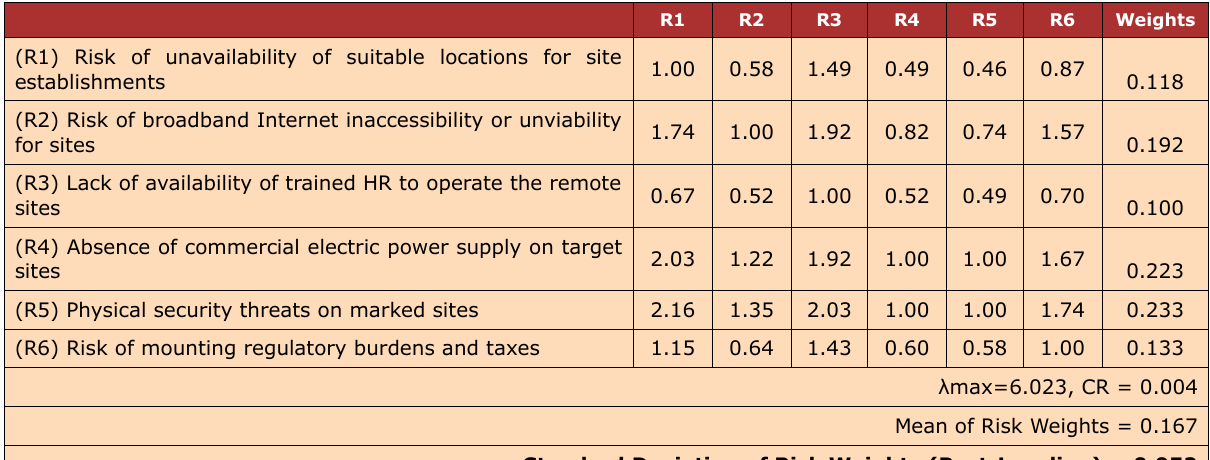
Table 2. Tele-Centres Program Risks – Post-Leveling Comparison Matrix & Relative